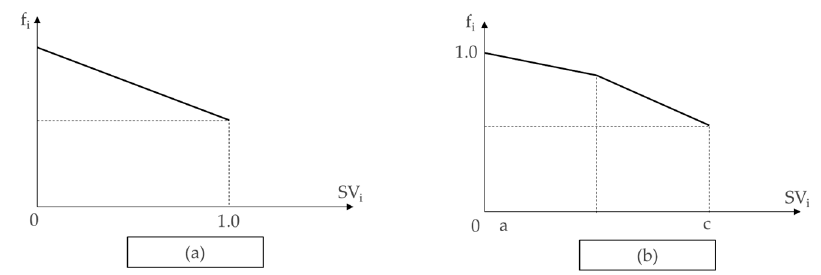
Figure 8. Alternative forms of the adjustment factor module.